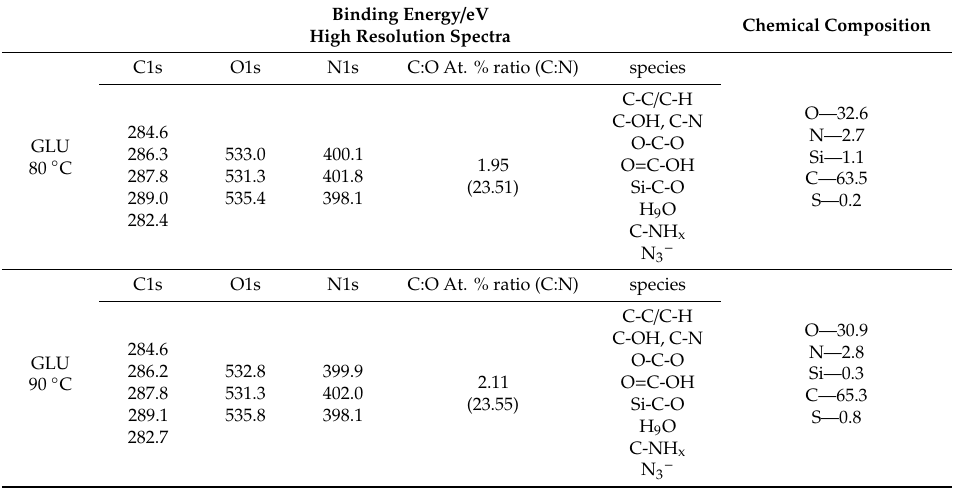
Table 3. C1s , O1s and N1s binding energies evaluated from the corrected XPS spectra deconvolution of glucan